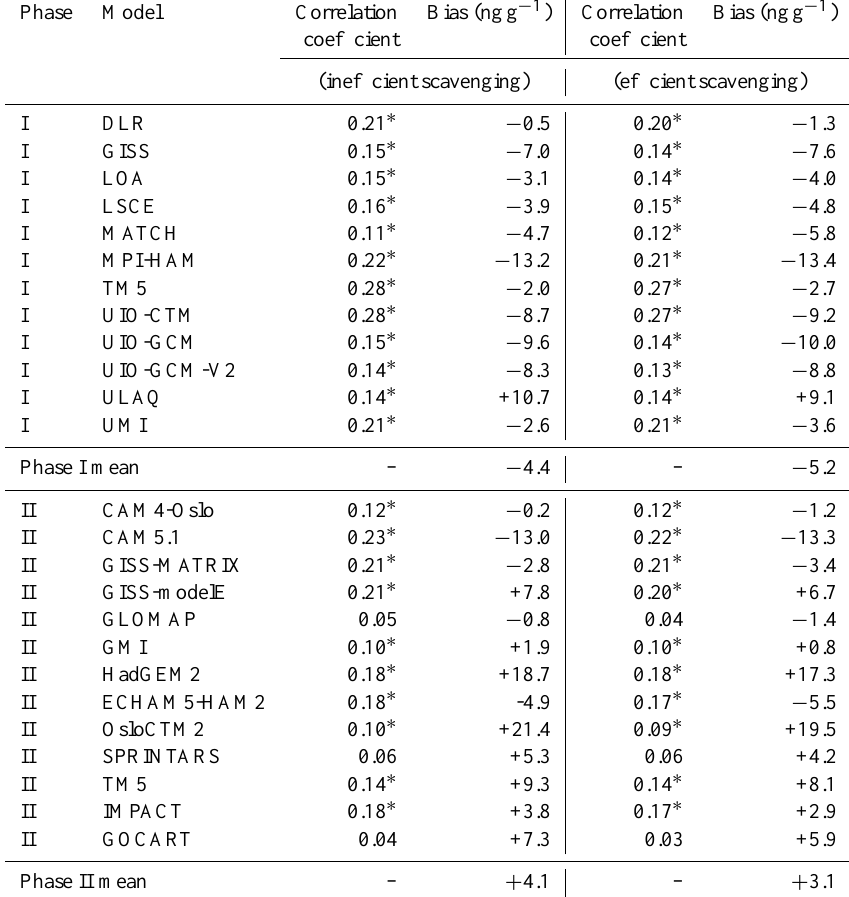
Table 2. Statistics of the comparison between models and observations. The correlation coefficients and significance levels are calculated by a linear regression fitted to all pairs of observations and corresponding modeled values from the same time and location. Biases are the differences between the mean of modeled values and the mean of observations. The mean observed BC-in-snow concentration is 19.2ngg − 1